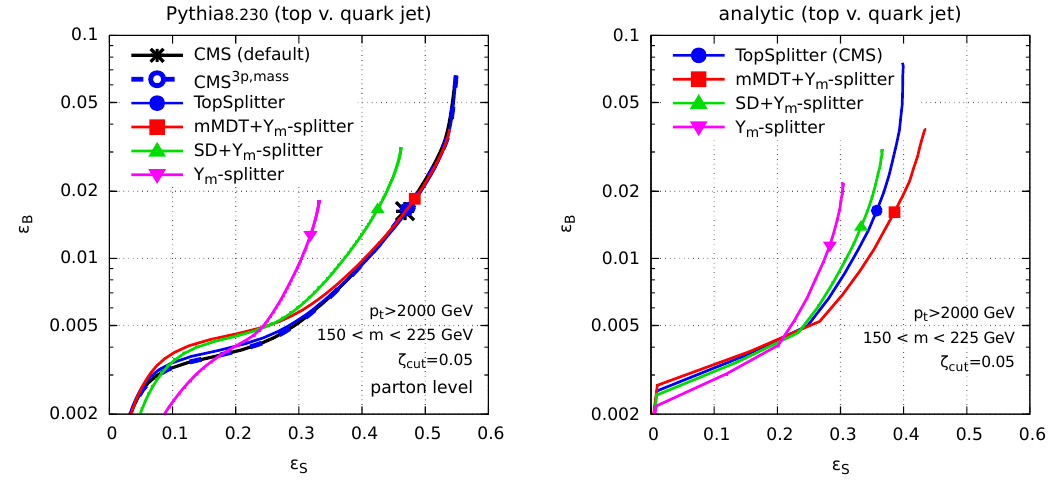
Figure 10. ROC curves corresponding to the m min scan shown in (cid:12)gure 7. This time, the Pythia results also include the default CMS tagger for comparison (in black). The thicker points correspond to the default value m min = 50